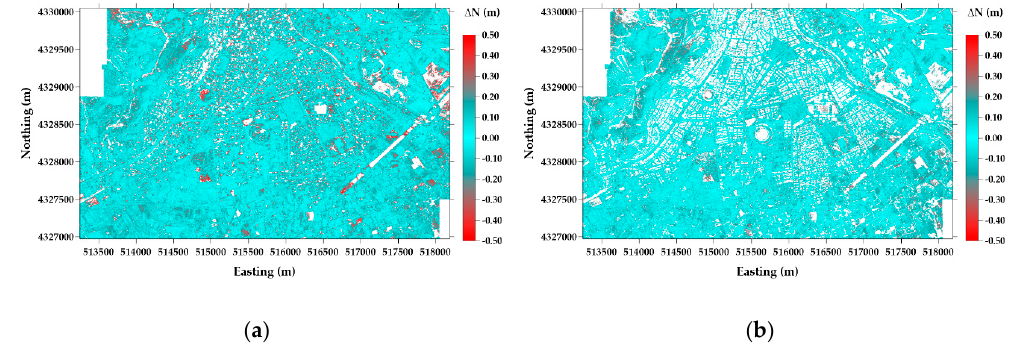
Figure 15. Differences between calculated local geoids and EIGEN6C4 global geoid surfaces. ( a ) Envi LiDAR; ( b ) Global Mapper.